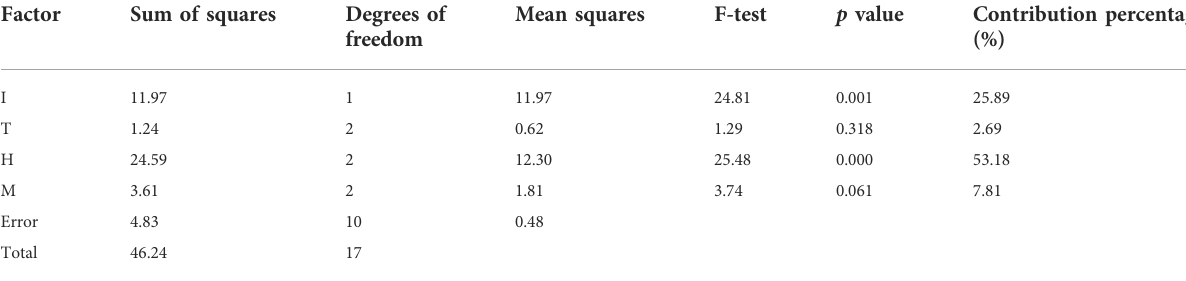
TABLE 4 Analysis of variance (ANOVA) of the main contributors for plantar pressure. Factor Sum of